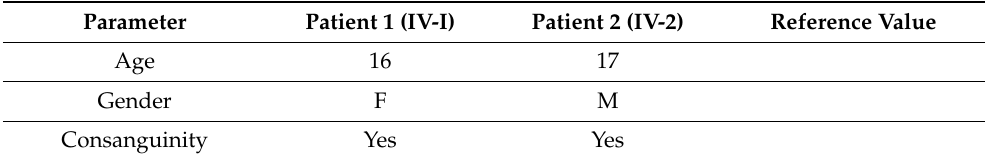
Table 1. Hematological, biochemical, and genetic findings in affected individuals with recessive congenital methemoglobinemia type 1, reported in the present